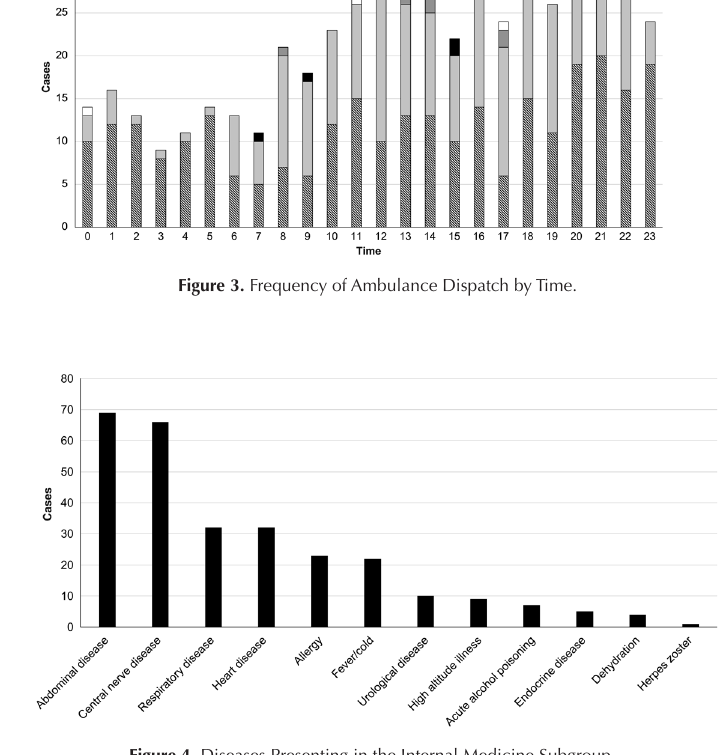
Figure 4. Diseases Presenting in the Internal Medicine Subgroup.